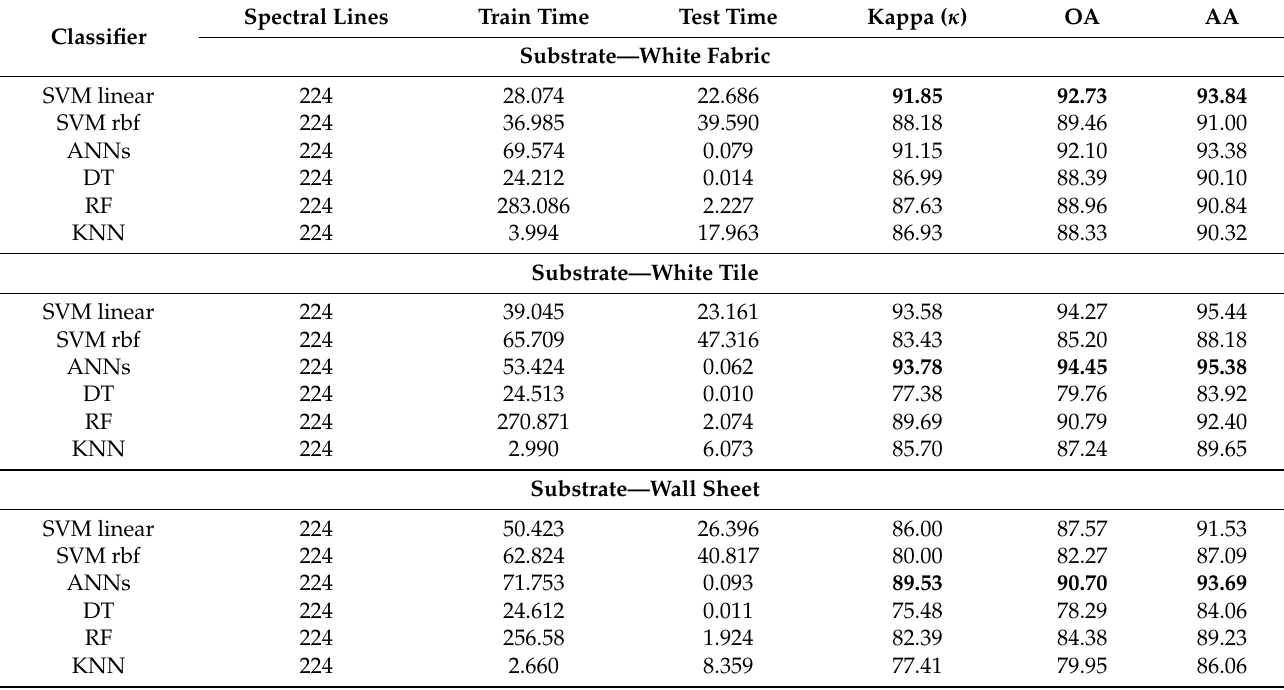
Table 8. Day-3: Blood vs. blood samples experimental results with full wavelengths. The best accuracies are